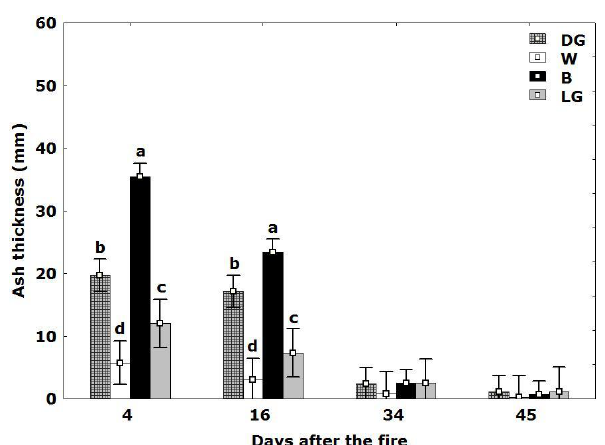
Fig. 4. Evolution of mean ash thickness in the sloping area in the post-fire period (bars show 95% confidence intervals). Different letters indicate significant differences (p<0.05) between ash types (DG, dark grey ashes; B, black ashes; LG, light grey ashes). icant differences in ash thickness among ash colour ( F = 5, p< 0 . 05), days ( F = 328, p< 0 . 001) and ash colour and days ( F = 6 p< 0 . 05). The greatest reduction of ash thickness was observed between 16 and 34 days after the fire.